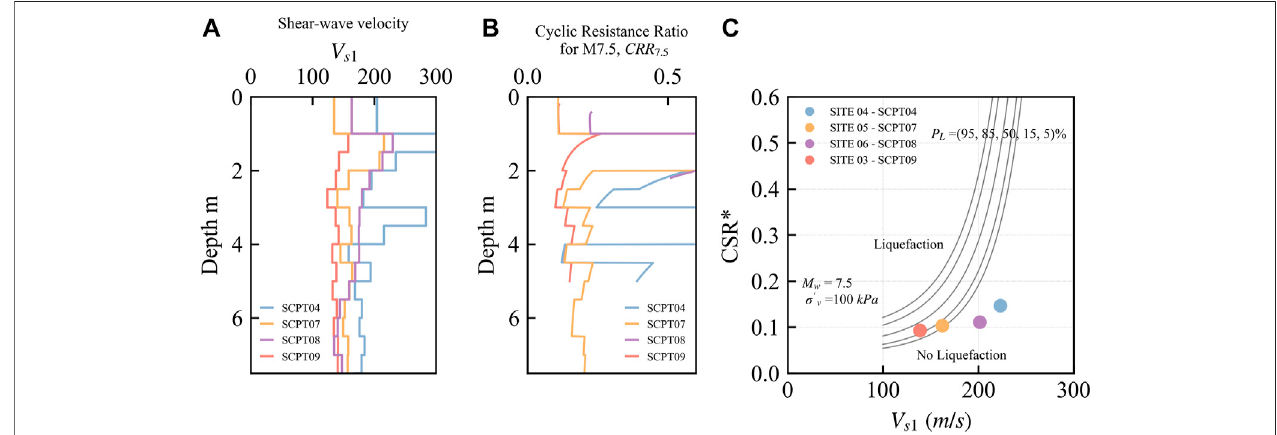
FIGURE13|(A) V s1 withdepth (B) Cyclicresistanceratioincriticallayers (C) PlotoftheprobabilisticliquefactioncurvesfromKayenetal.(2013)using M w (cid:1) 7.5, σ ′ v (cid:1) 100 kPa and FC (cid:1) 35%, compared against results from each